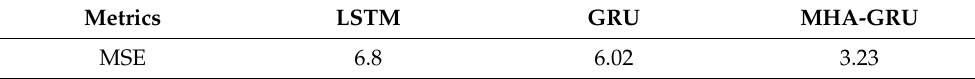
Table 2. Performance comparison amongst different machine learning